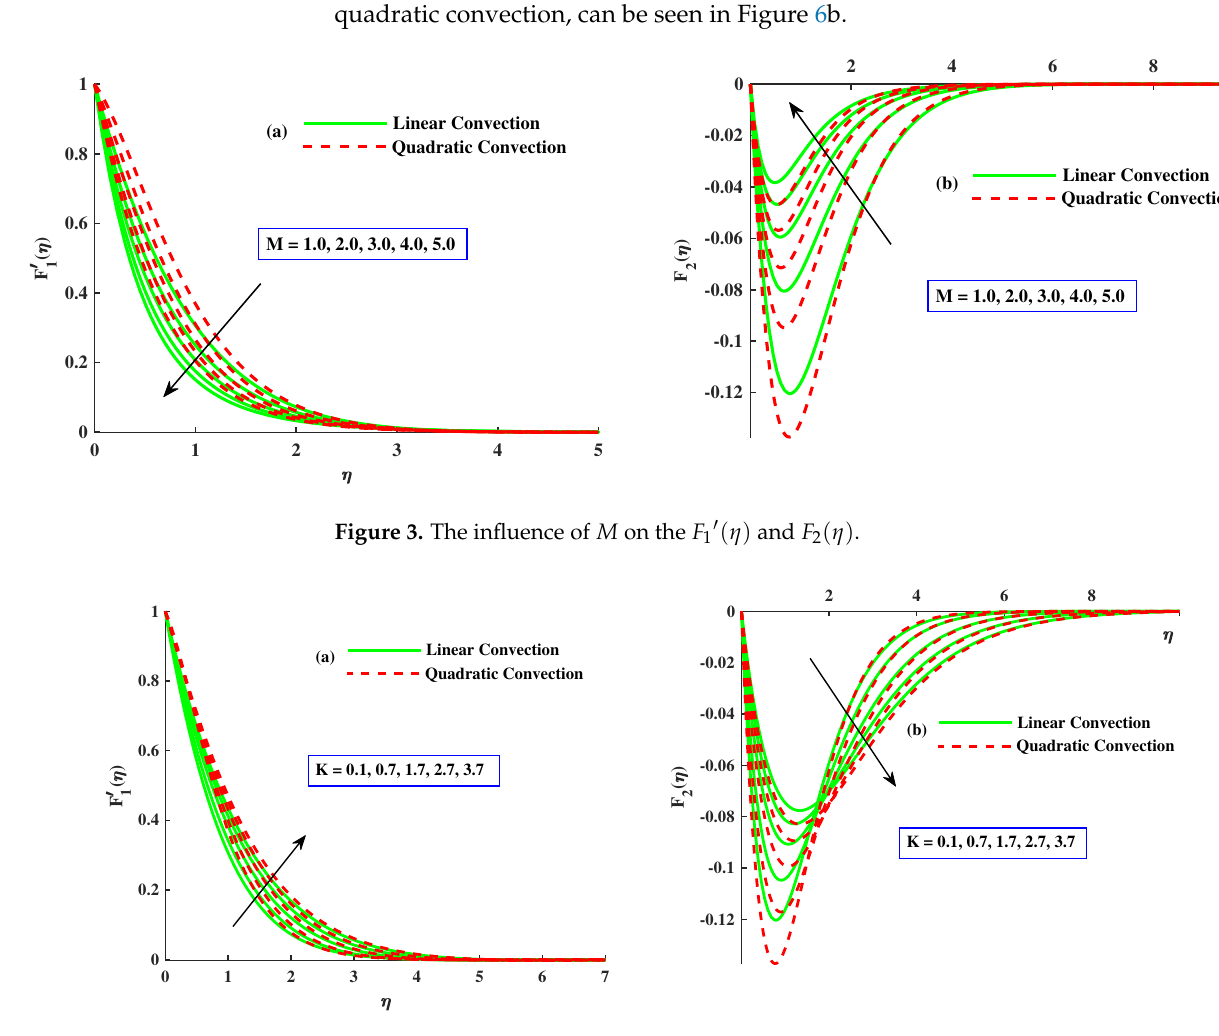
Figure 4. The influence of K on the F 1 (cid:48) ( η ) and F 2 ( η ) .